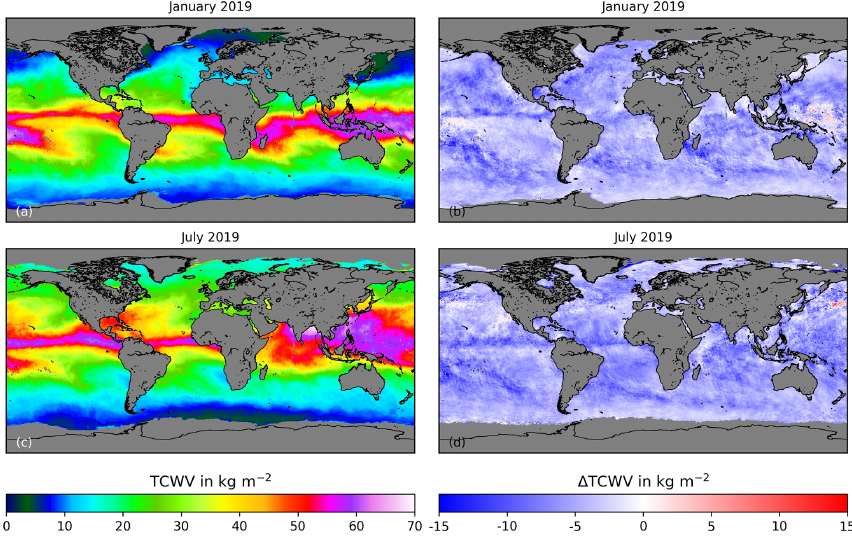
Figure 12. As Fig. 8 but for the SSMIS TCWV